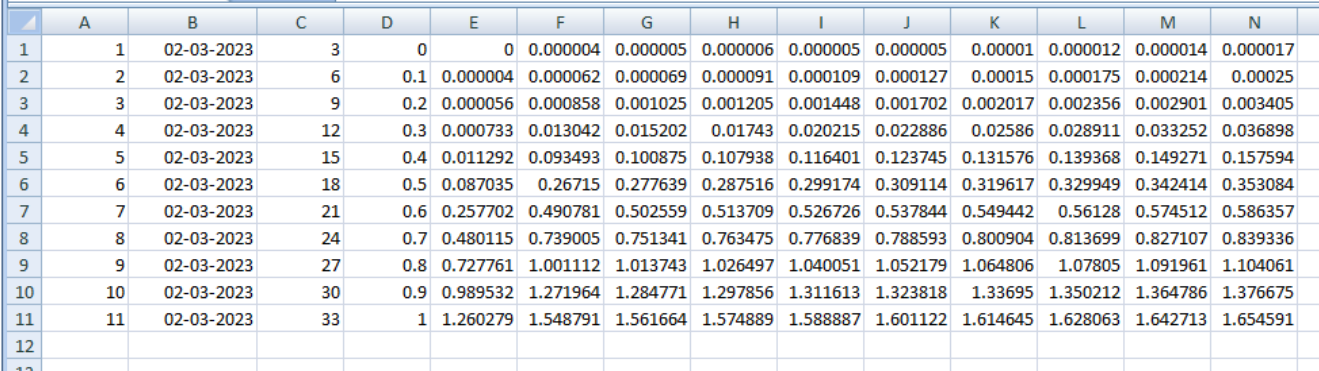
Figure 5: Screenshot of the data file (DataFile_10.csv) displayed within Excel sheet after completing tenth round of data acquisition in Loop-10 by the programme Sub_Prog_2.vi.